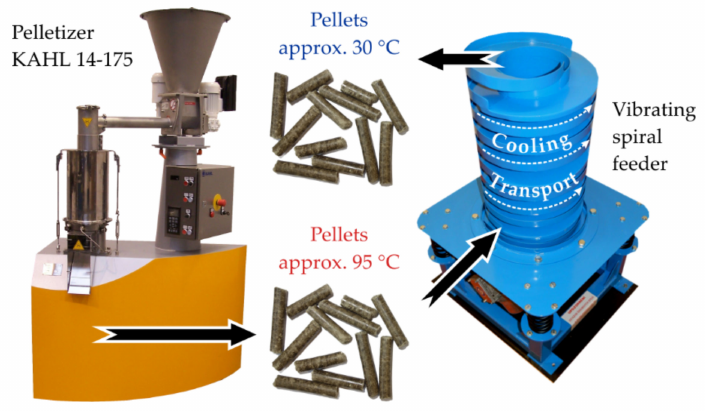
Figure 4. Schematic of production process—pelletizing and cooling of pellets via vibrating spiral